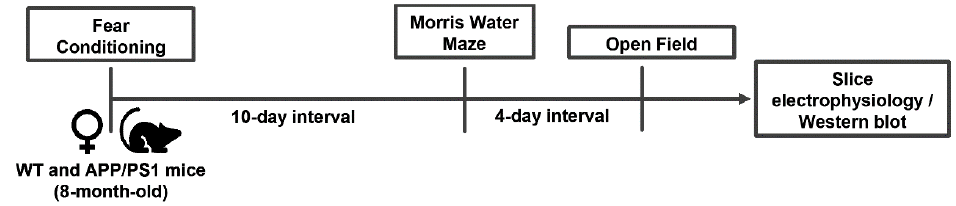
Figure 1. Overall schematic presentation of the experimental protocol.